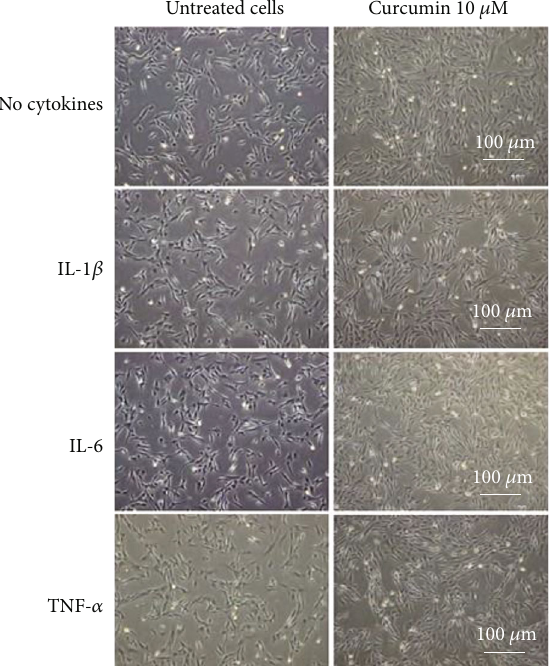
Figure 3: Representative images of SW982 cell morphology detected by phase-contrast microscopy after 24h incubation with curcumin (10 μ M) and cytokines (50 ng/ml).